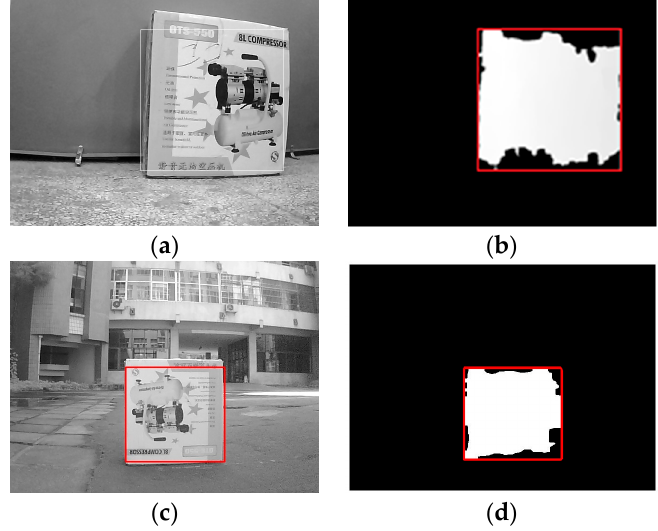
Figure 14. Results of target grab: ( a ) target grabbing from the disparity indoor; ( b ) target detection using images indoor; ( c ) target grabbing from the disparity outdoor; ( d ) target detection using images outdoor.